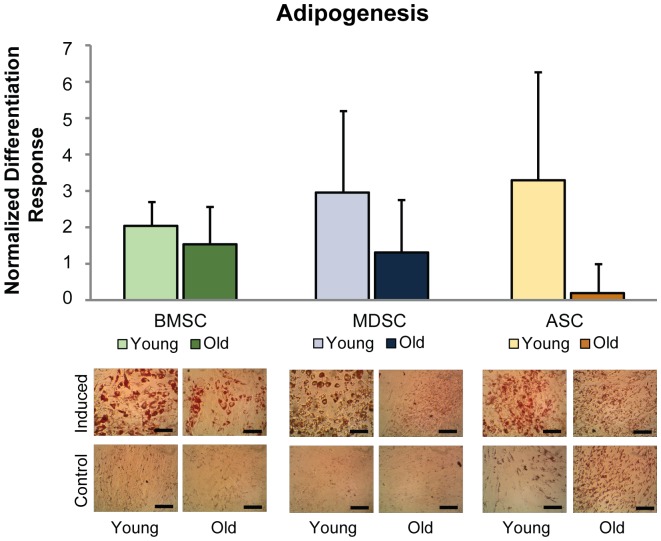
MSC adipogenic differentiation. Old age impaired the adipogenic potential of BMSCs, MDSCs, and ASCs.Quantification of eluted ORO stain revealed significant decreases in the overall, control-normalized differentiation response based on age as a factor (p<0.05). However, individual comparisons within tissue sources showed no significant differences between age groups. Qualitatively, staining showed that lipid production of induced samples was reduced for old BMSCs and MDSCs compared with their young counterparts. No readily apparent, age differences were observed for these cells in control conditions. Conversely, lipid production in old ASCs was noticeably greater than young ASCs in control conditions, while induced samples were similar. Error bars depict standard deviations. (Scale bars  = 100 µm).